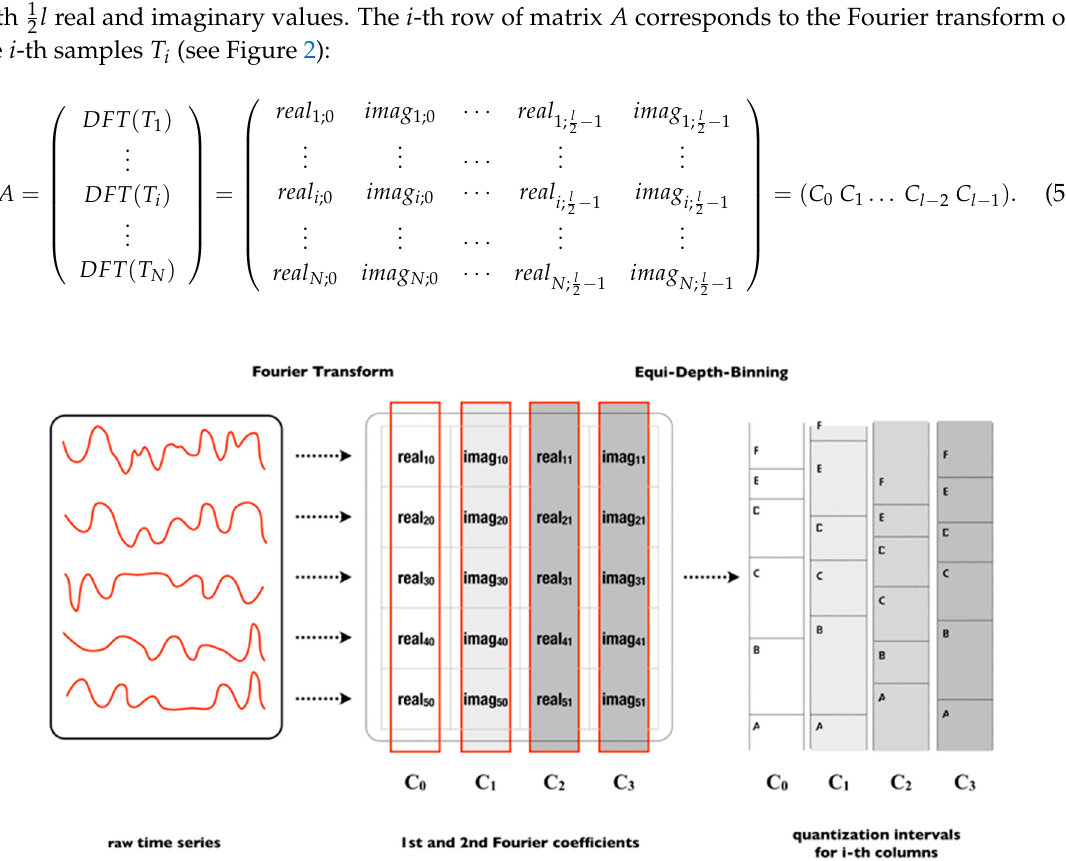
Figure 2. A set of time series is used to generate the bins and breakpoints in MCB. First, Fourier transform is applied and later is applied equi-depth binning for each i -th columns. The j -column C j corresponds to either the real or imaginary values of all N train